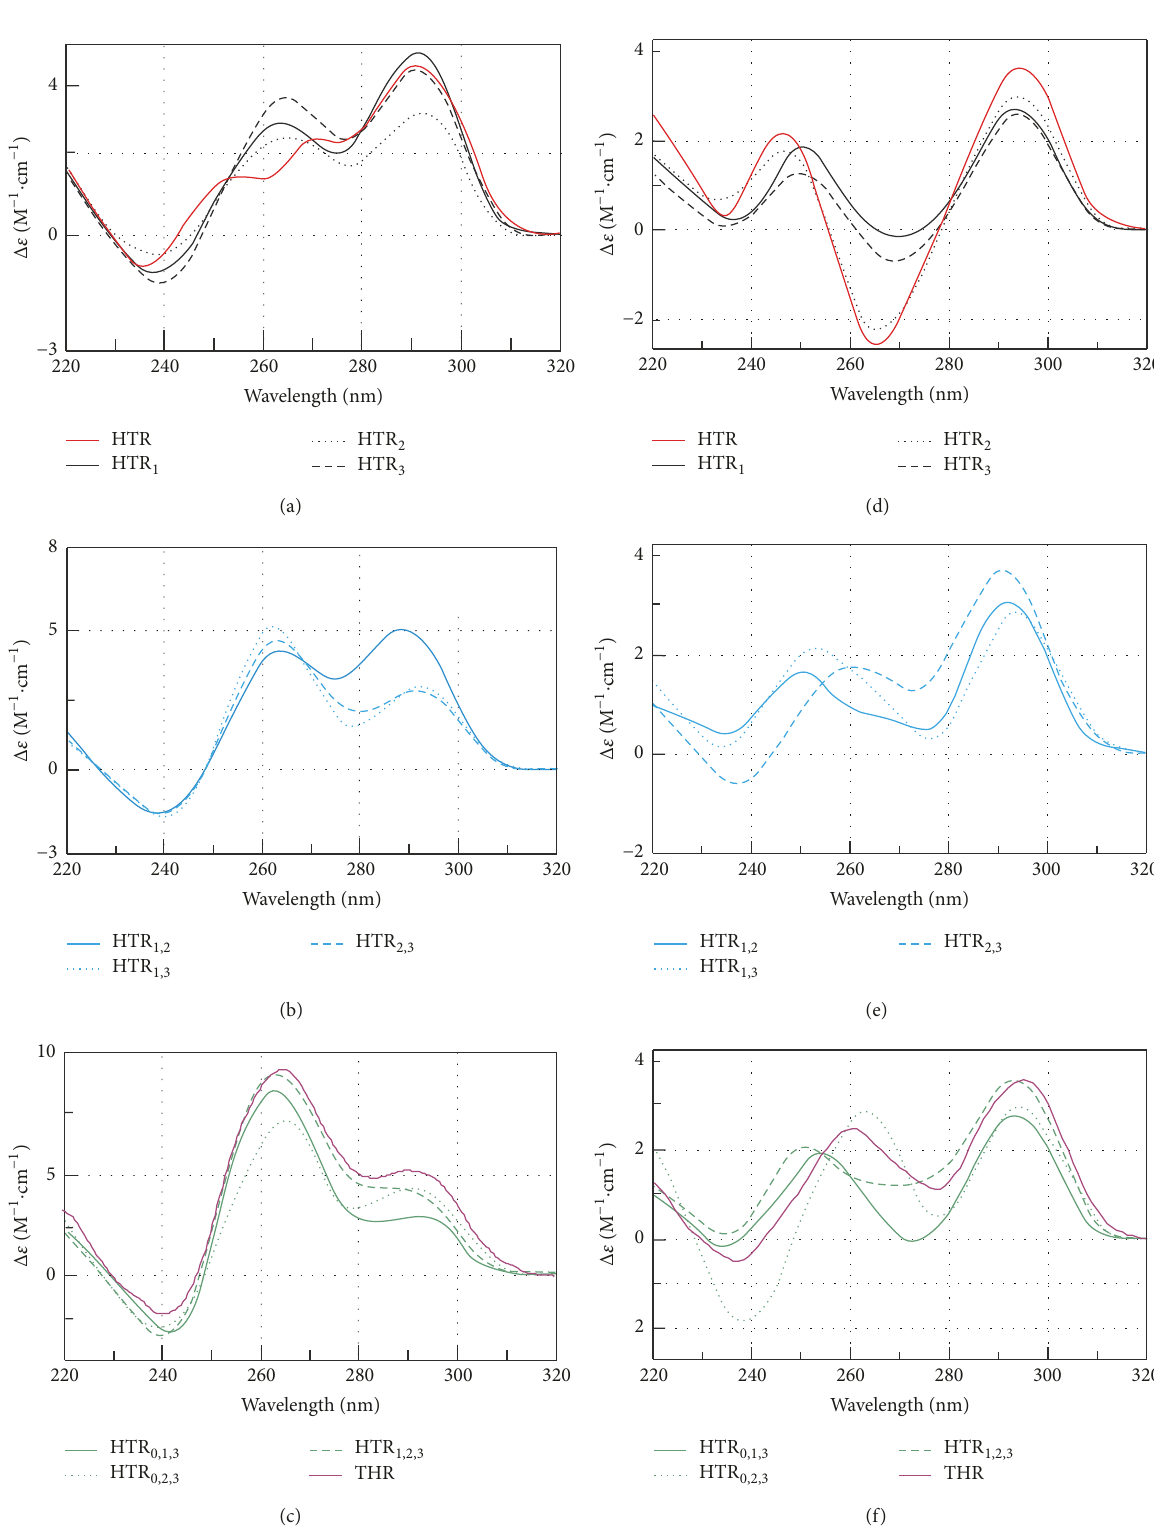
Figure 2: CD spectra of oligonucleotides used in this study in a 25 mM modified Britton-Robinson buffer (pH 7.0) in the presence of 50mM KCl (a–c) and 50 mM NaCl (d–f). The HTR and THR spectra are shown in red and magenta, respectively. Each DNA sample was annealed at 95 ∘ C for 5 min and then allowed to cool for ∼ 1h to the initial temperature at which the sample was kept at the beginning of the measurement